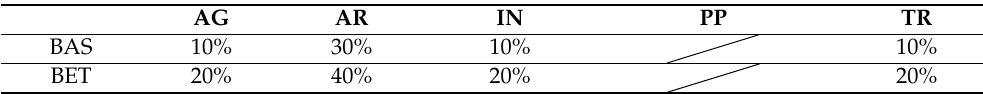
Table 3. Emissions reduction scenarios in